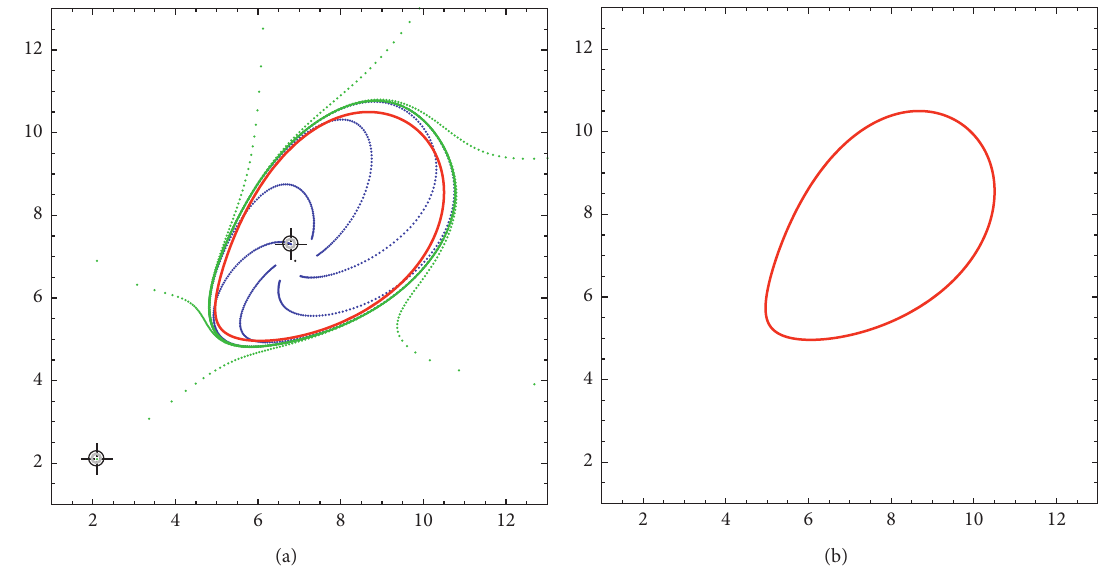
Figure 2: Trajectories (a) and invariant curve (b) for p � 2 . 9 and q � 3.